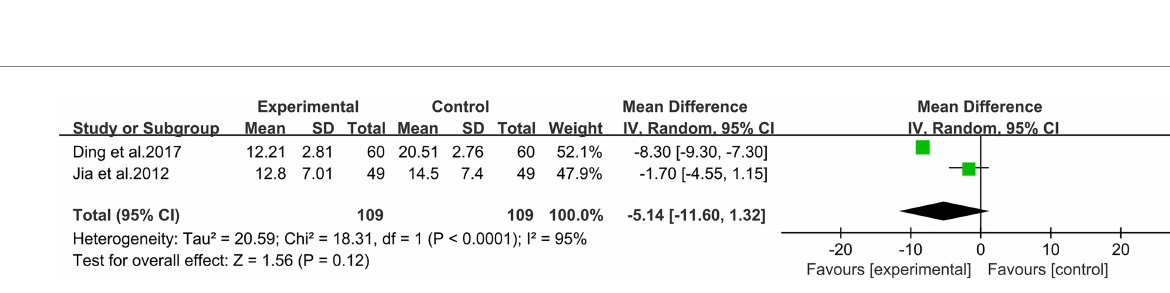
FIGURE 7 Meta-analysis for comparison of HAMD-17 between the experimental and control groups.